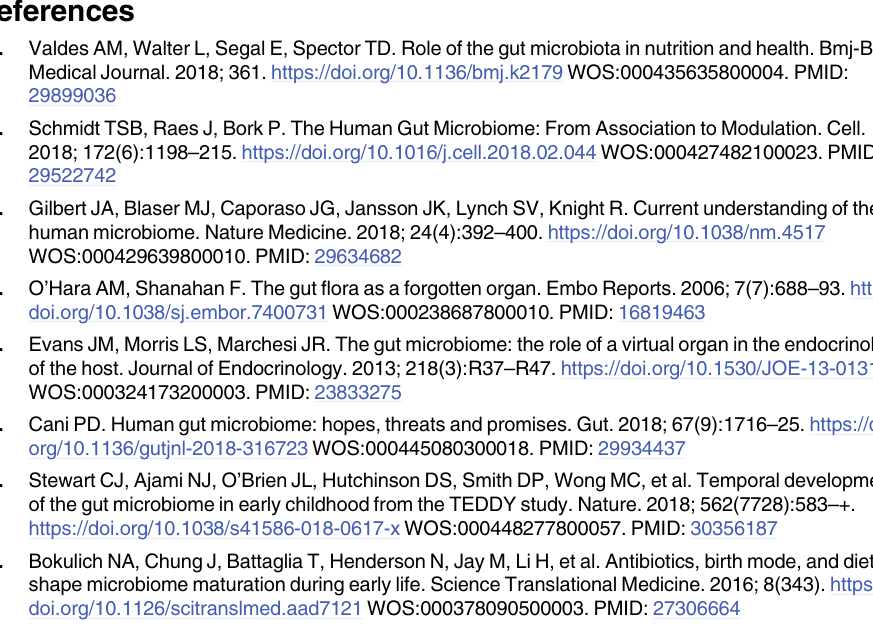
S14 Table. The effects of sex and age on gut microbiota of normal and sterile crested ibises. The microbiota characteristics (taxonomic composition and alpha diversity indexes) were tested with linear mixed effect models to evaluate the effects of sex and age on gut microbiota in normal and sterile crested